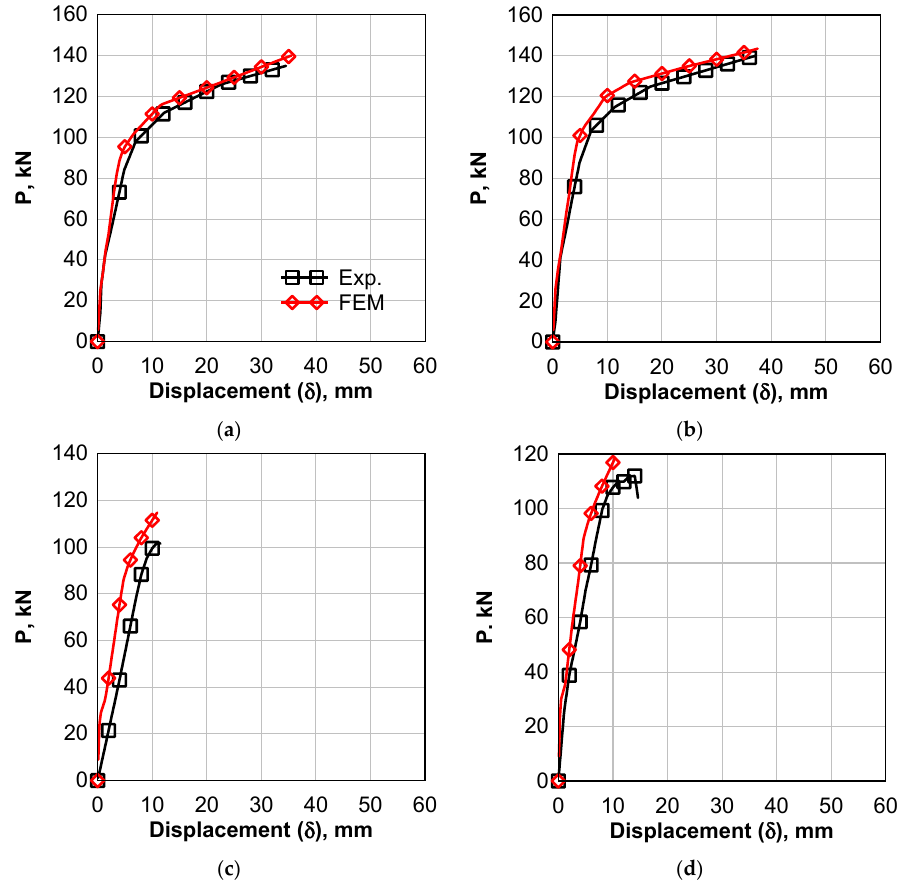
Figure 12. Experimental versus Numerical Load Displacement Curves of Beams with 360 × 90 mm 2 Opening. ( a ) unstrengthened tension; ( b ) strengthened tension; ( c ) unstrengthened shear; ( d ) strengthened shear.